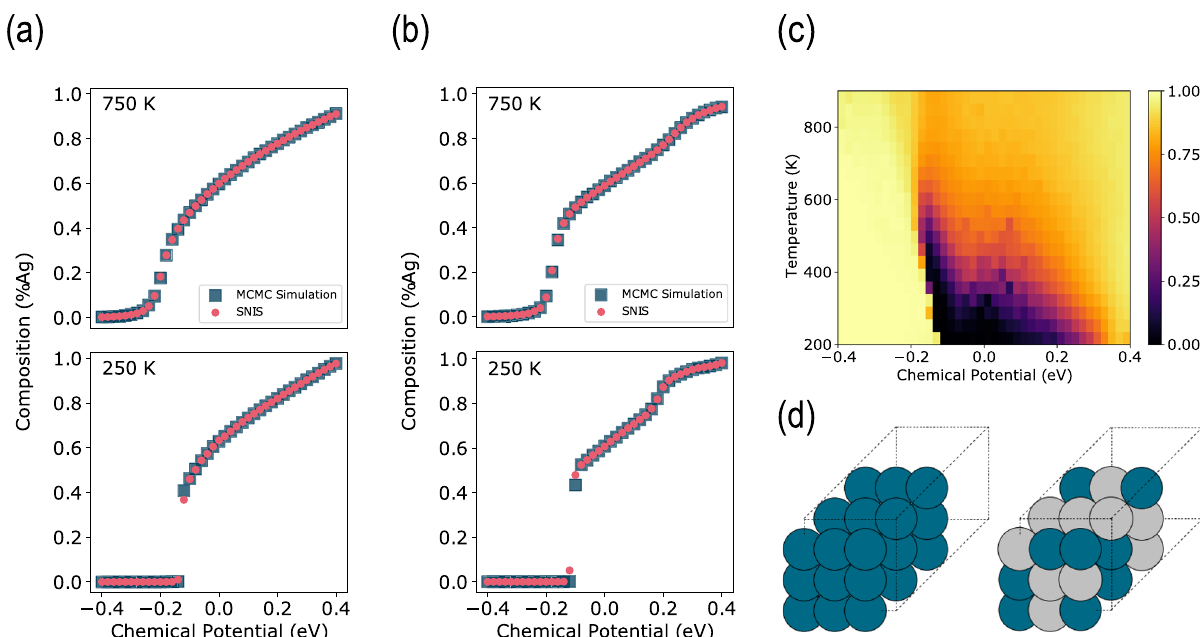
Fig. 4 SEGAL applied to 27-site AgPd alloy. Composition vs. Δ μ computed with MCMC and self-normalized importance sampling (SNIS) at temperatures of 750 K (top) and 250 K (bottom) using ( a ) cluster expansion and ( b ) crystal graph convolution models for U . c Normalized effective sample size of SEGAL over the training region. Estimates of NESS are taken with 10,000 samples each. d Samples from SEGAL at T = 250 K, Δ μ = − 0.16 eV (left) and T = 250 K, Δ μ = − 0.04 eV